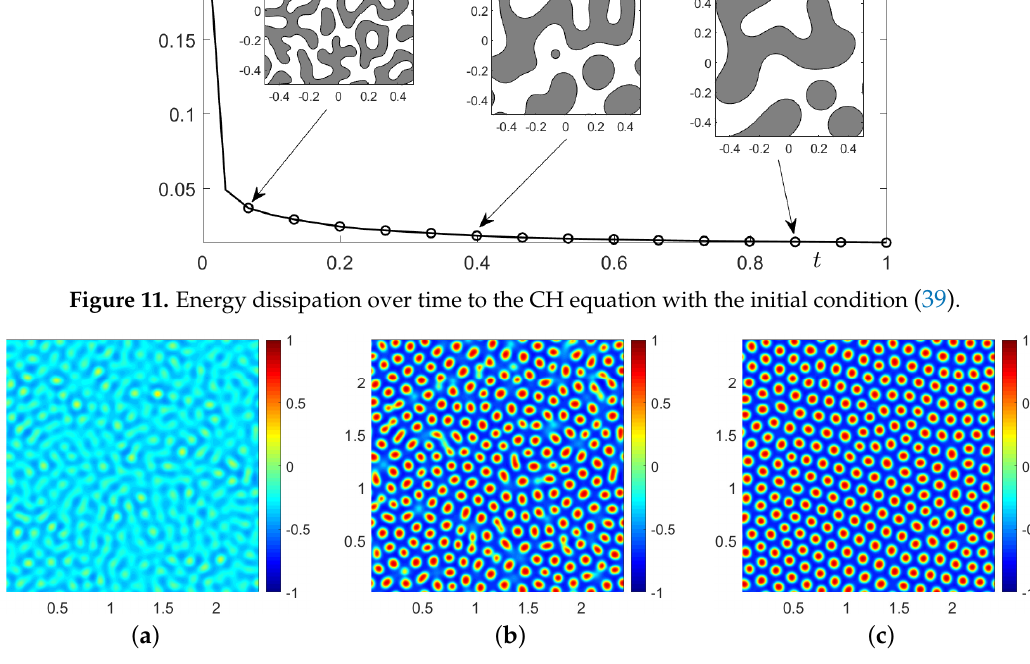
Figure 12. ( a – c ) are the snapshots of numerical solutions of the nonlocal CH model (4) with the initial condition (43) at t = 40 ∆ t , 80 ∆ t , and 2000 ∆ t , respectively. For colored figures, see the manuscript of web version.